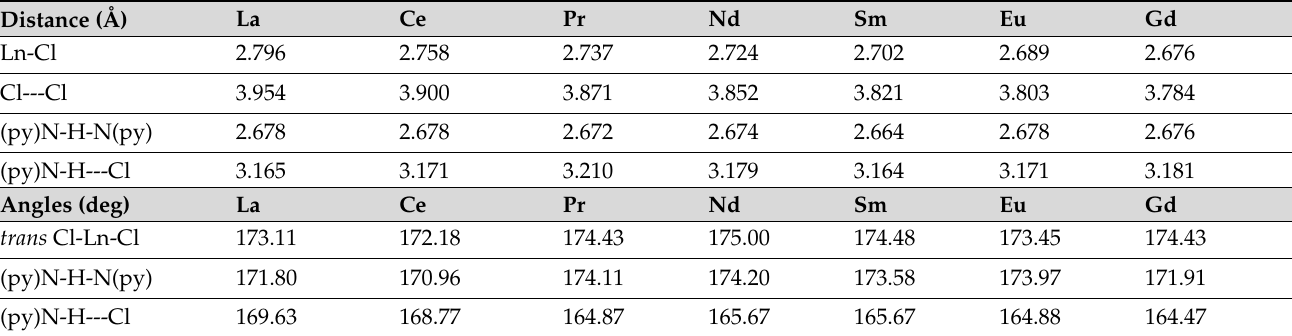
Table 2. Average, select, metrical data for Ln-6 .